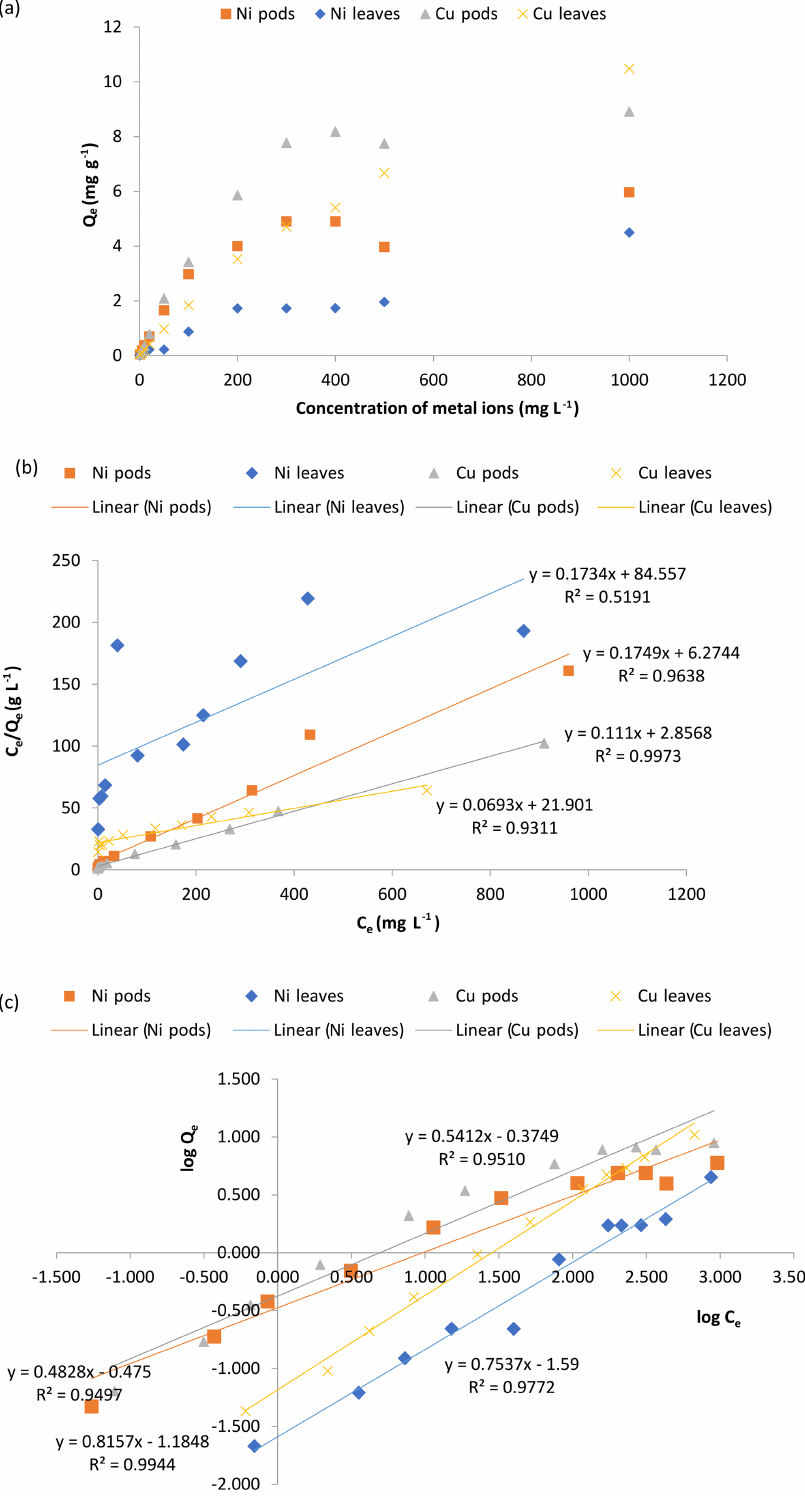
Figure 6. The effect of the initial metal ion concentration (a) , and plots of the Langmuir (b) and Freundlich (c) isotherms for the adsorption of Ni(II) and Cu(II) ions by Delonix regia pods and leaves. The experimental conditions were as follows: a pH of 4 and 5, a contact time of 30min, an adsorbent dosage of 0.5g and a metal ion concentration of 1–1000mgL − 1